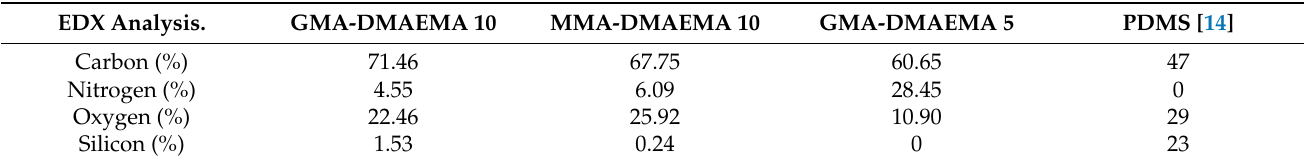
Table 4. Energy-dispersive X-ray analysis of the elemental composition of modified membranes compared to the bare PDMS membrane composition from the literature [14]. EDX